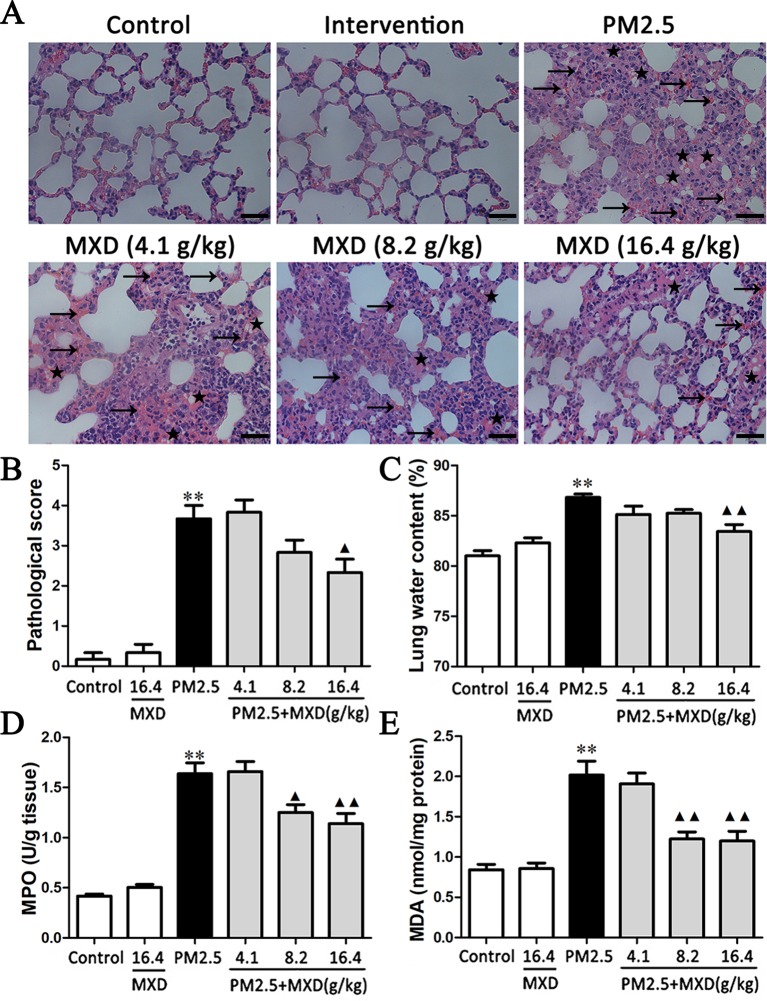
Effects of MXD on PM2.5 induced pathological changes and biochemical indexes changes in lung tissue after a 5-day continuous treatment. (A) Effects of MXD on the pathological changes of the lung tissue induced by PM2.5. The local hemorrhage was marked with arrow, and the local edema was marked with lightning bolt. Scale bar, 20 μm (×400). (B) Quantified scoring of pathological changes in lung tissue (n = 6). (C) Effects of MXD on the lung edema induced by PM2.5 (n = 8). (D) Effects of MXD on MPO activity in lung tissues (n=6). (E) Effects of MXD on MDA content in lung tissues (n = 7). Data are expressed as mean ± SEM. **p < 0.01 vs. Control group; ▴
p < 0.05, ▴▴
p < 0.01 vs. PM2.5 group.